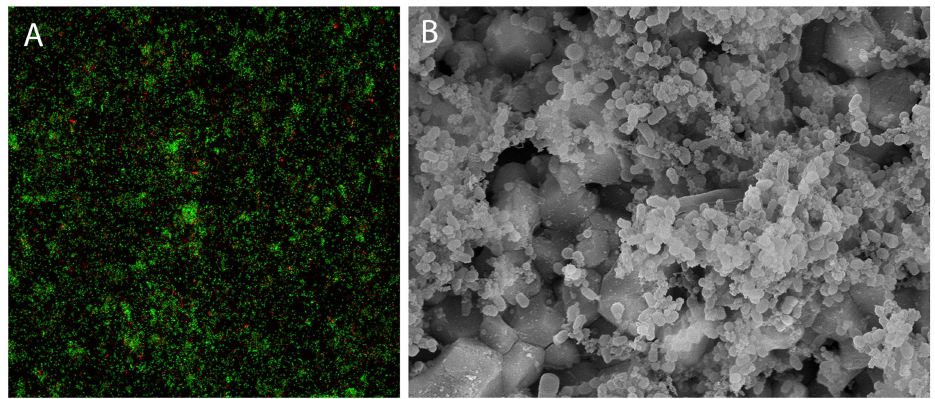
Fig 1. Representative confocal (A) and scanning electron (B) micrographs representing Porphyromonas gingivalis ATCC 33277biofilm after 96h of growth. BacLight Live/Dead strain was used to assess the viabilityof cells in CLSM distinguishing viablebacteria depictedas green and non-viable as red stainedcells.